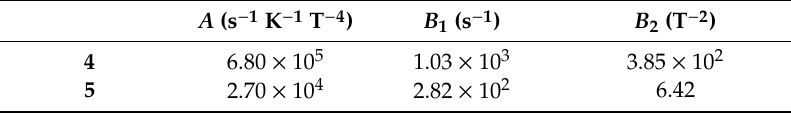
Figure 3. Comparison of the field-dependent relaxation time ( τ ) at 1.8 K for two distinct major (filled circles) and minor (open circles) relaxations observed for 4 (green), and 5 (blue). The solid black lines represent fits to the experimental data using the appropriate magnetic relaxation pathways considering both the quantum tunneling and direct processes (Equation (1)). Table 4. Summary of field-dependent ac magnetic data 1 for 4 and 5.